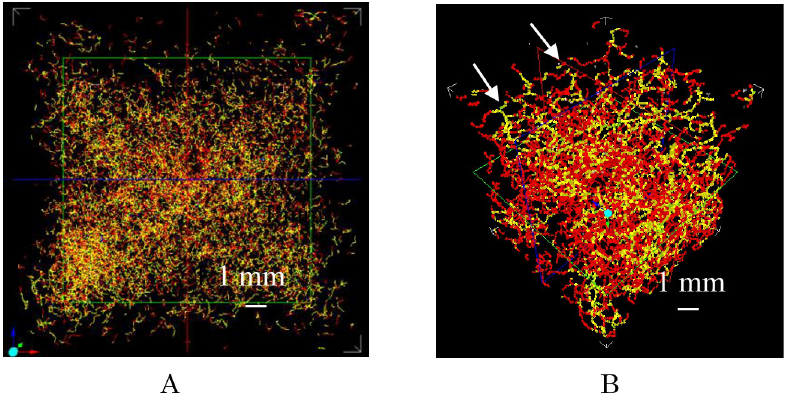
Fig 3. Distribution of three dimensional-cracks in new mortar sample A and the 120 year-sample. A. Crack widths from 0.05 mm (red) to 0.25 mm (purple) in the 120 year-sample. B. Crack widths from 0.138 (red) to 0.552 mm (purple) in mortar sample